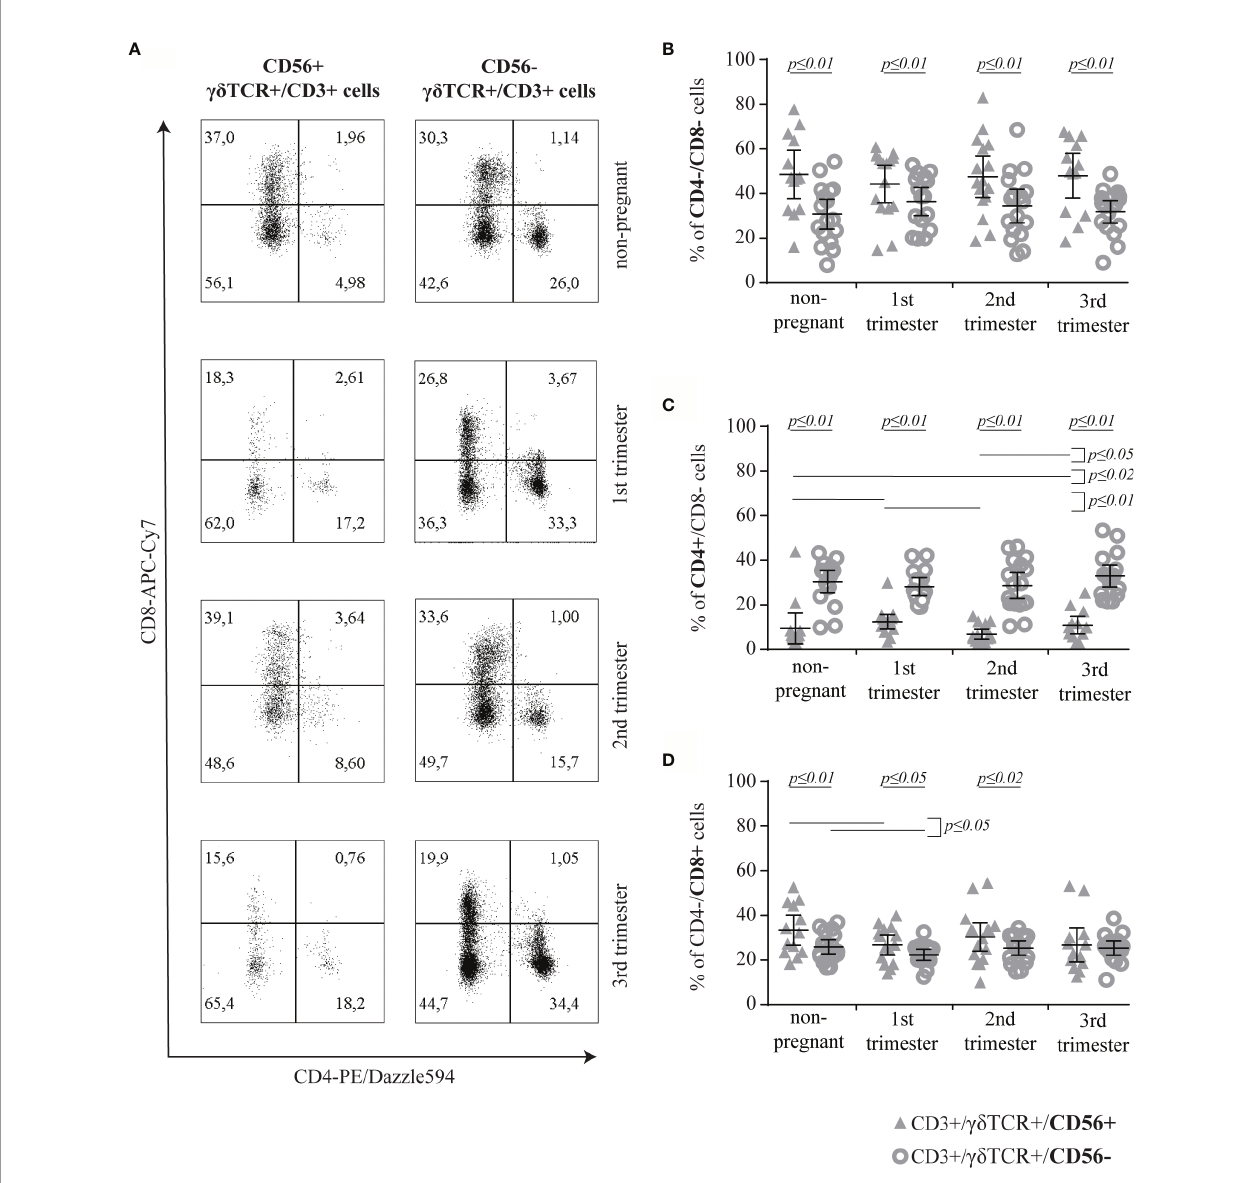
FIGURE 2 | Representative CD4/CD8 dot plots of peripheral blood CD56+ or CD56 − gd T cells (CD3+/ gd TCR+) in non-pregnant and pregnant (1 st , 2 nd , and 3 rd trimester) women (A) Percentage of CD4 − /CD8 − (B) , CD4+ (C) and CD8+ (D) cells among CD56+ or CD56 − gd T cells (CD3+/ gd TCR+) in peripheral blood of non- pregnant (n = 17) and pregnant [1 st (n = 16), 2 nd (n = 17), and 3 rd (n = 17) trimester] women. The mean is depicted by a horizontal line with the 95% con fi dence interval represented by whiskers. The individual data points are shown as triangles (CD3+/ gd TCR+/CD56+) or circles (CD3+/ gd TCR+/CD56 − ). Signi fi cant differences between the groups were determined as followed: Panel B: Differences between the CD56+ and CD56 − gd T cell subpopulation were tested by paired-samples-t- test; Panels C and D: Statistical analysis was performed by using the Mann-Whitney test (non-pregnant vs 1 st trimester vs 2 nd trimester vs 3 rd trimester) or the Wilcoxon test (CD3+/ gd TCR+/CD56+ vs CD3+/ gd TCR+/CD56 − ). Signi fi cant differences are depicted by a horizontal line above the respective data